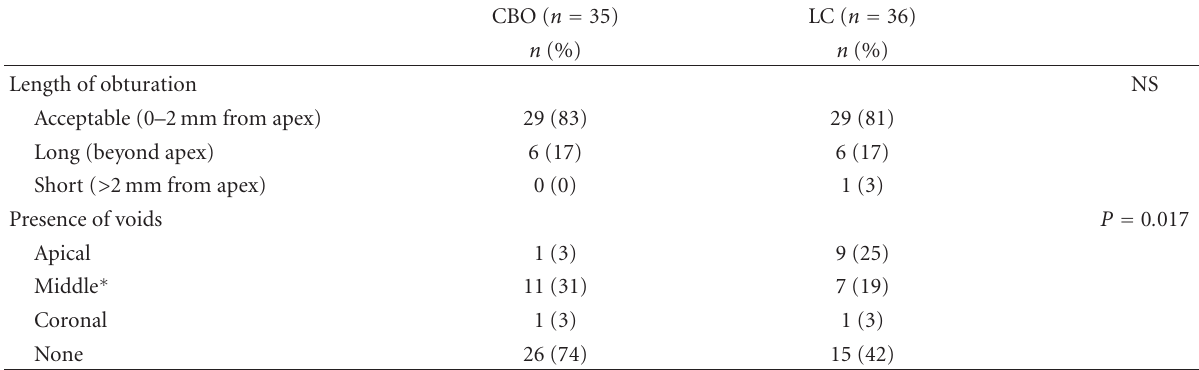
Table 5: Length of obturation and presence of voids among treatment